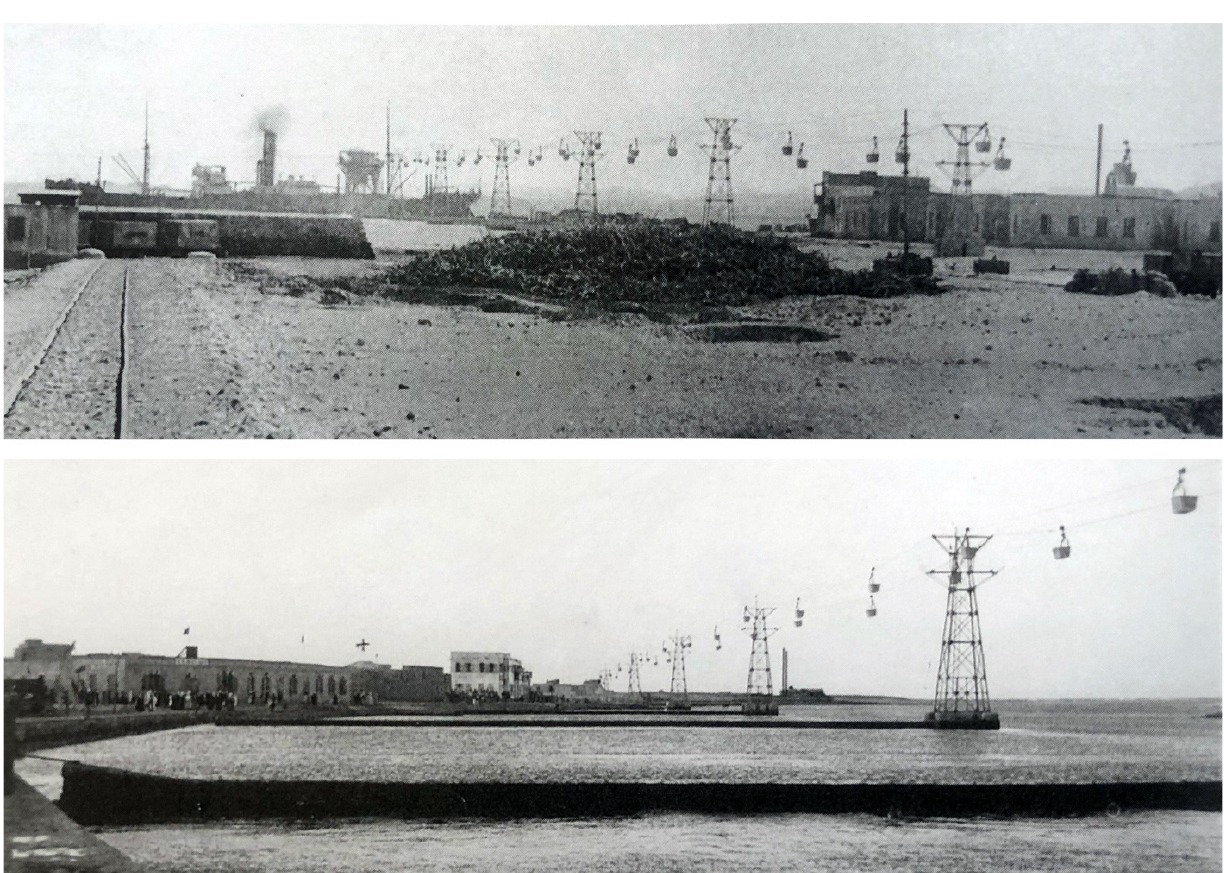
Figure 4. The cable cars penetrating the coastal industrial plant (top) and extending to the port overlooking the old town (bottom). Source: Pellegrini (2011, p.